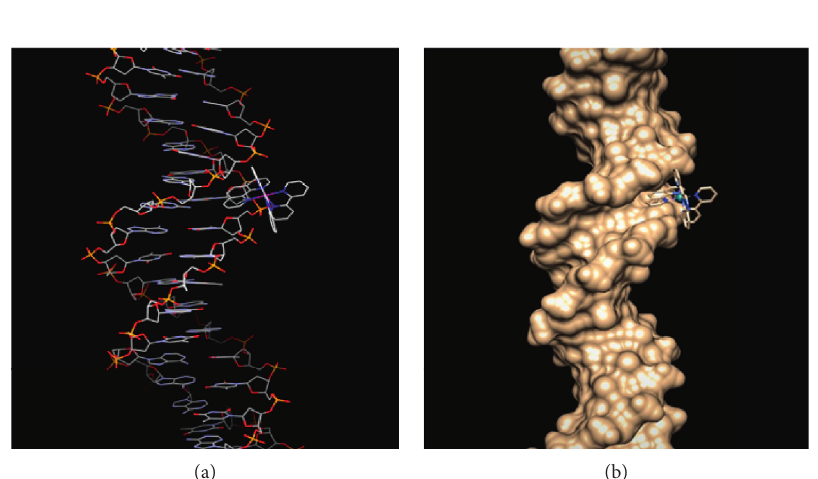
Figure 10: (a) Visualization of the interaction of 2 via phen moiety to the specific region of the sequence of DNA (5D2Q). (b) Interaction of complex 2 through the phen moiety with the hydrophobic DNA sequence (PDB: